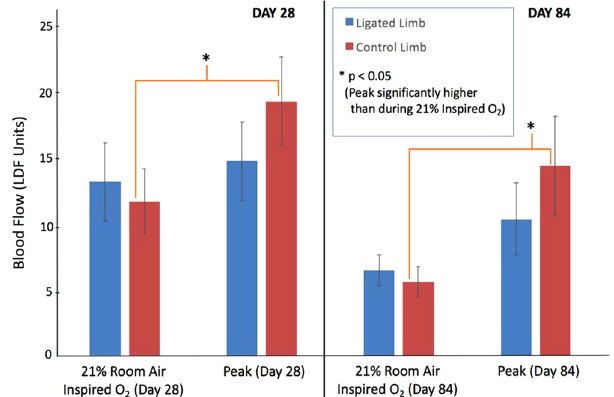
Figure 4. Blood flow during stable period 1 minute prior to tourniquet application (21% inspired O 2 ) vs. Reactive Hyperemia Peak. Laser Doppler data for Day 28 (n = 10) and Day 84 (n = 12) both show a peak significantly higher than 21% room air in the control limb, but not in the ligated limb.